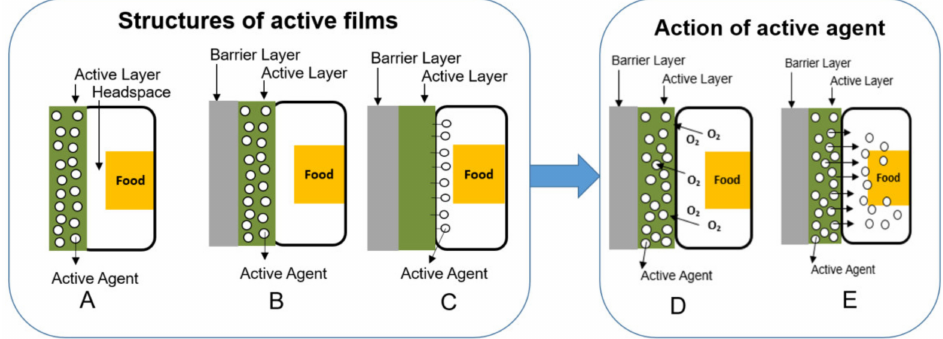
Figure 1. Structure of active film for active food packaging with headspace: ( A ) monolayer film with an active agent, ( B ) two-layer film with an active agent in the inner layer and ( C ) two-layer film with active substance immobilized or fixed on the surface of the film. ( D , E ) Schematic representation of active scavenging and releasing systems,